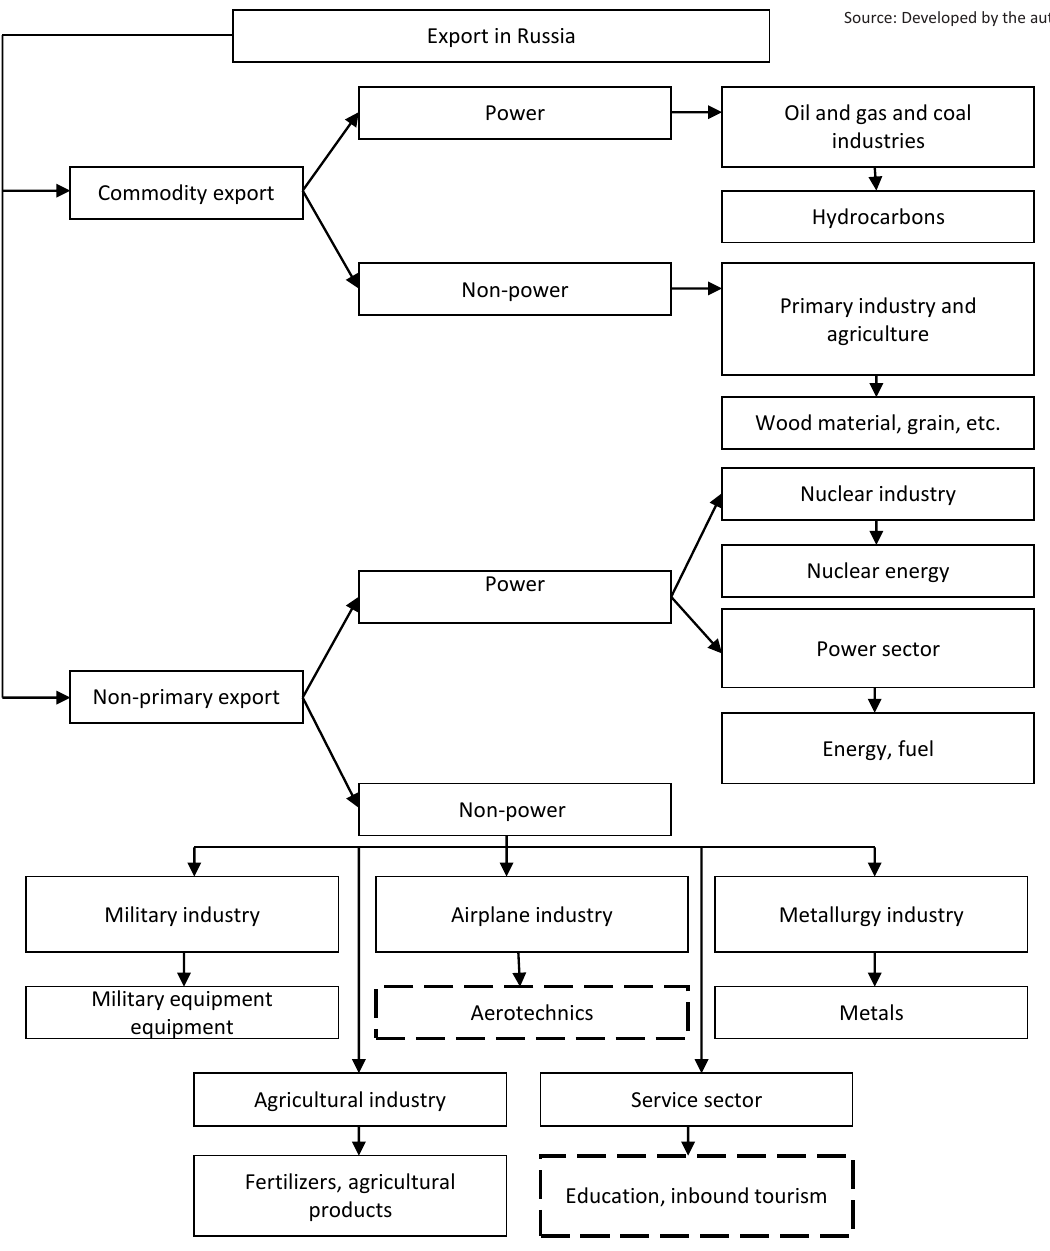
Figure 1. The main existing and promising industries in Russia, manufacturing products,